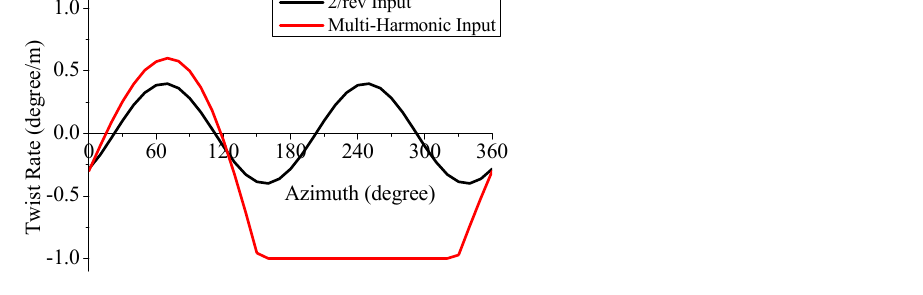
Figure 17. Optimal control schedules of uniform twist control with optimal 2/rev input and multi- harmonic input for condition B.